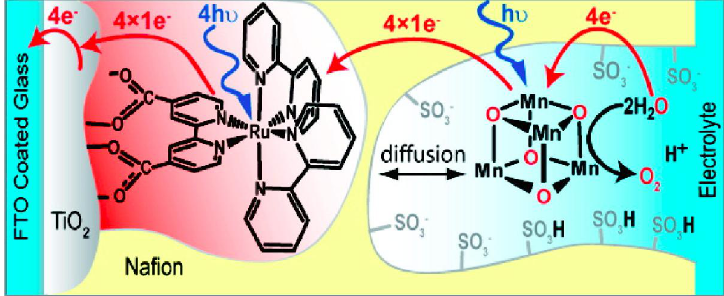
Figure 3. Mn-tetramer/Nafion water splitting catalytic system. Photoanode are made of a titania layer sensitized with the dye, [Ru(bipy) with the Mn-oxo tetramer, [Mn from American Chemical